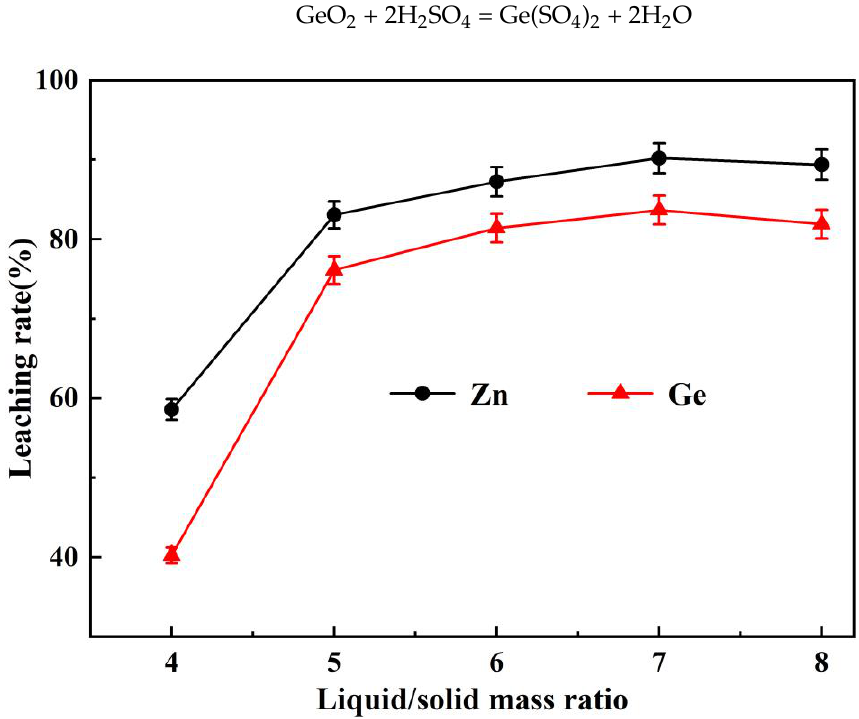
Figure 5. Effect of L/S mass ratio on metal leaching rate (initial acidity = 160 g·L − 1 , leaching time = 240 min, leaching temperature = 90 °C, and stirring speed = 400 r·min − 1 ).